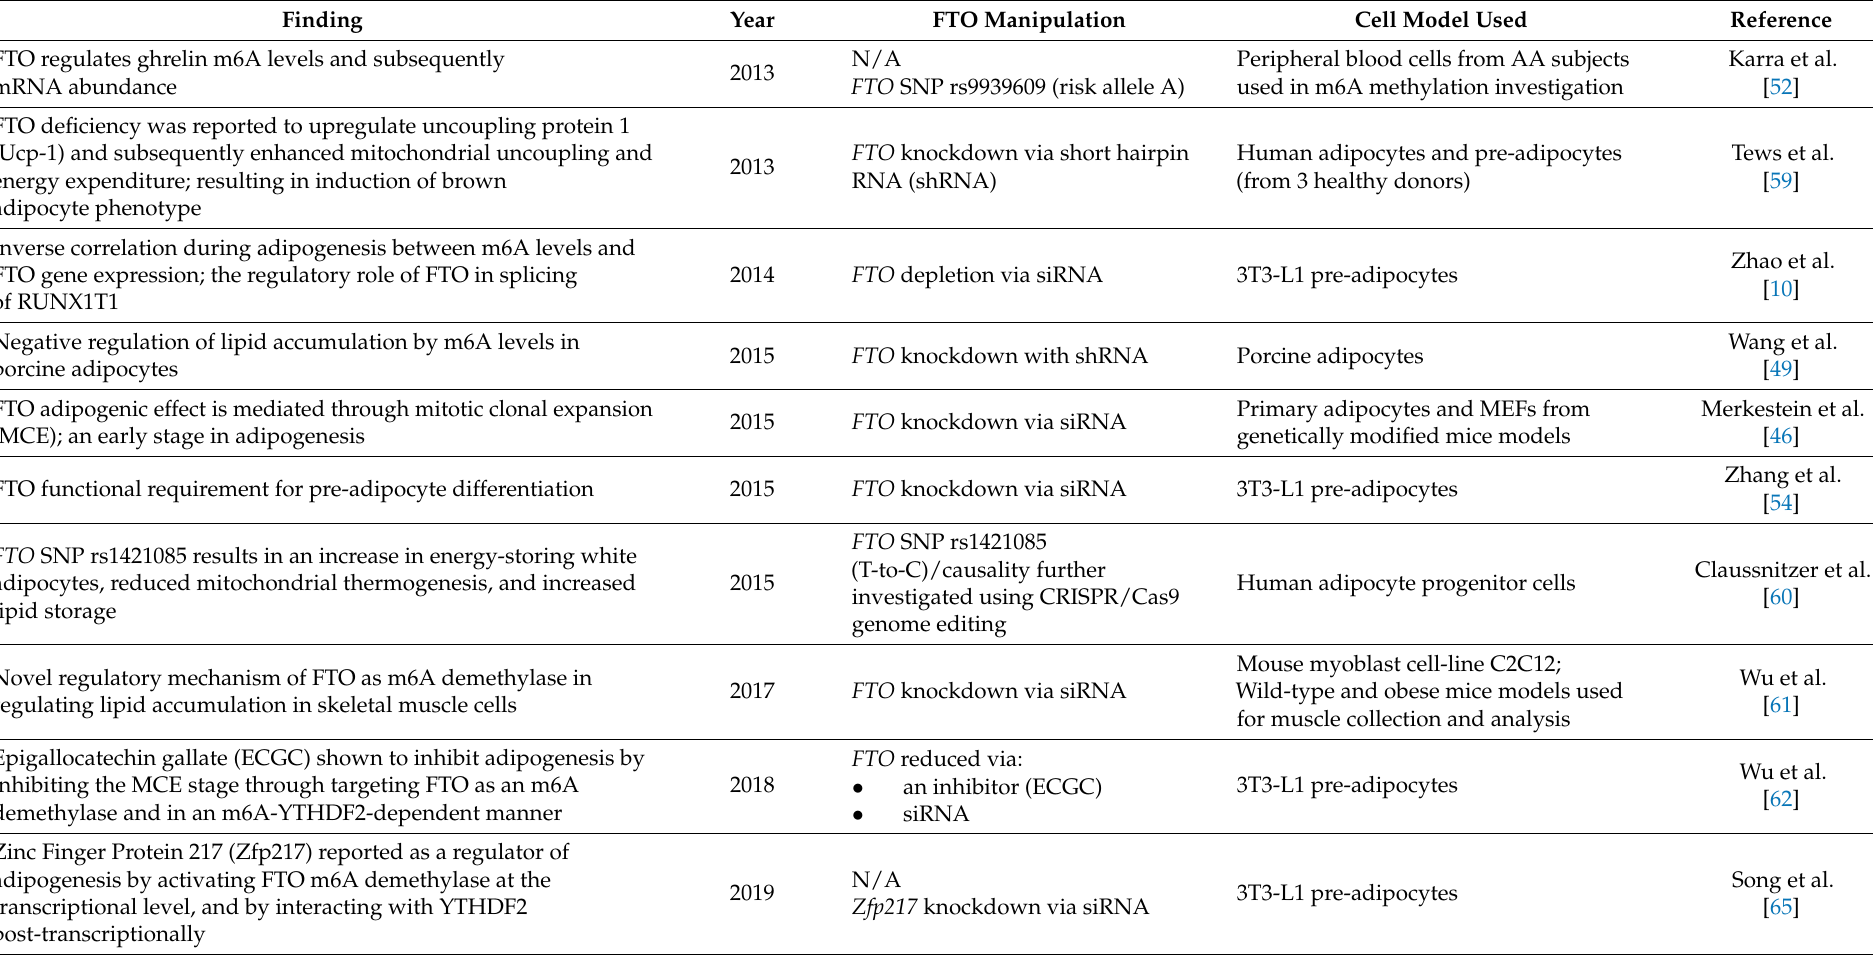
Table 1. Summary of studies on FTO molecular mechanisms in relation to